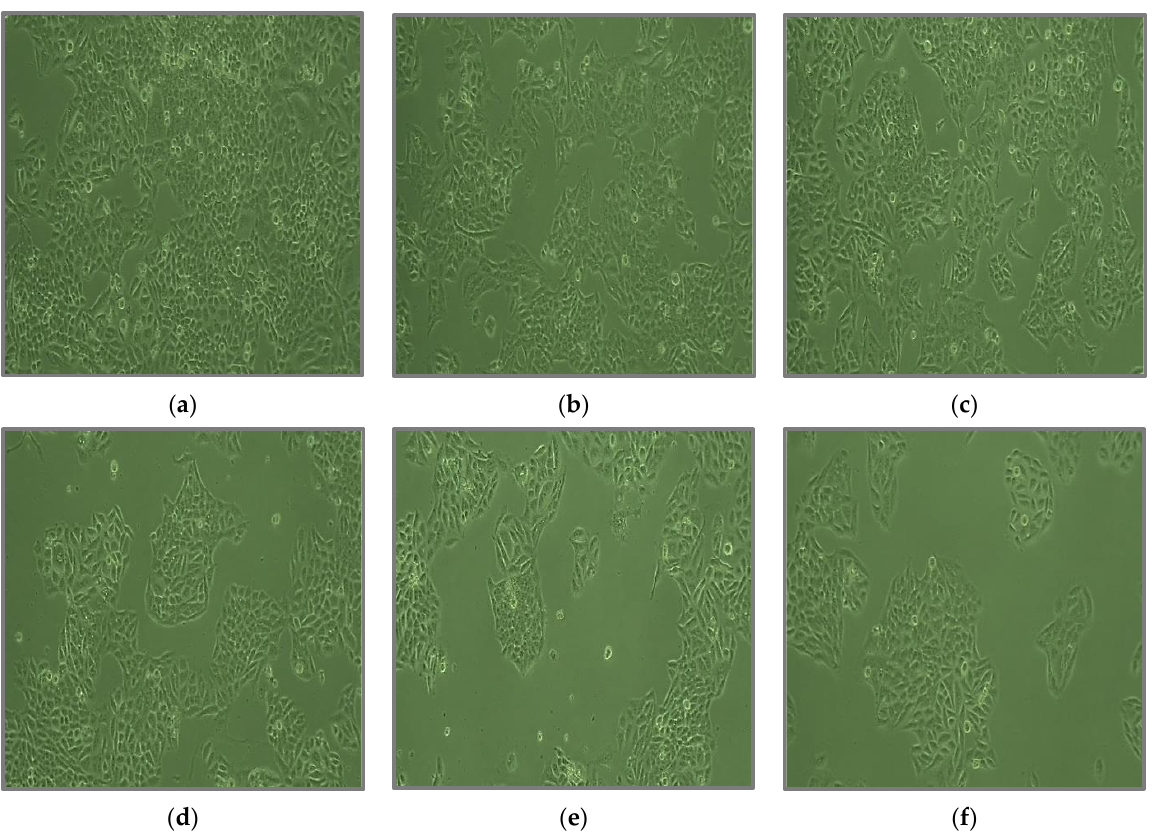
Figure 11. Anticancer activity of Ni 2+ doped HApNPs. ( a ) control, ( b ) 6.25 µg /mL, ( c ) 12.5 µg /mL, ( d ) 25 µg /mL, ( e ) 50 µg /mL, ( f ) 100 µg /mL. Table 3. Anticancer activity of Ni 2+ -doped HApNPs tested on HeLa cells. Sample